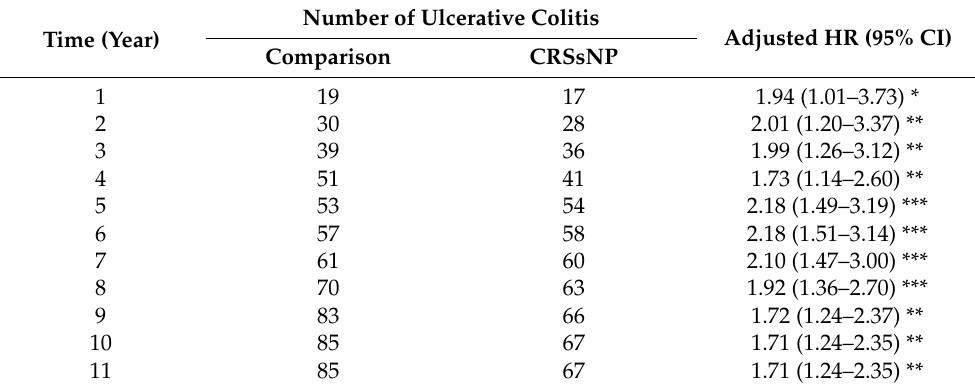
Table 5. Hazard ratios for incident ulcerative colitis associated with CRSsNP development by time since CRSsNP diagnosis.